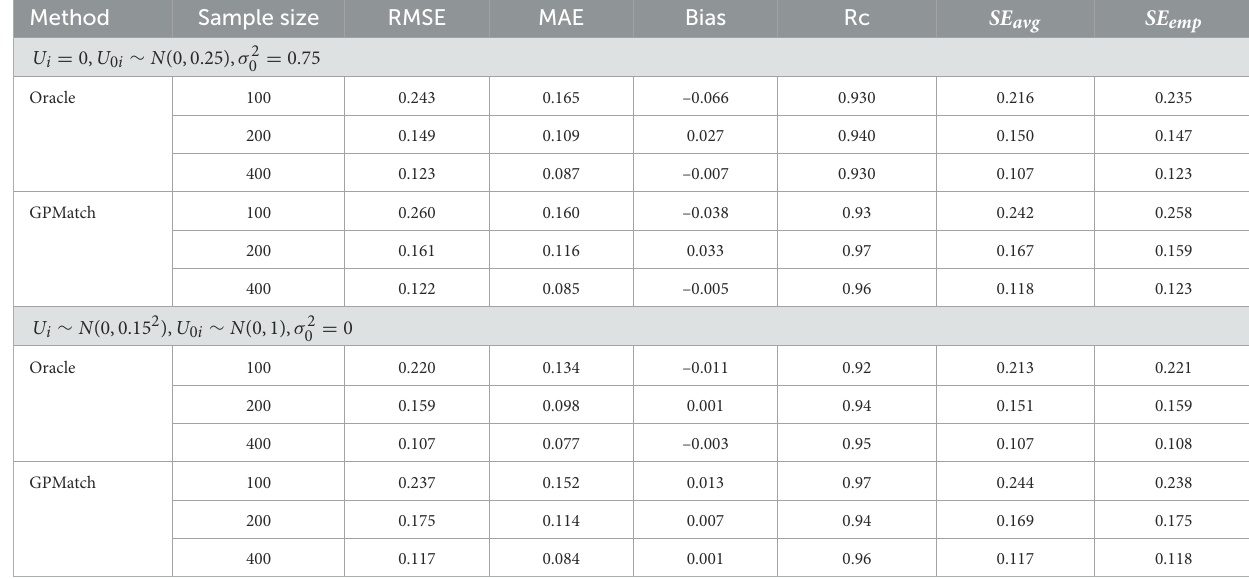
TABLE 2 Results of ATE estimates under the single covariate simulation study setting.